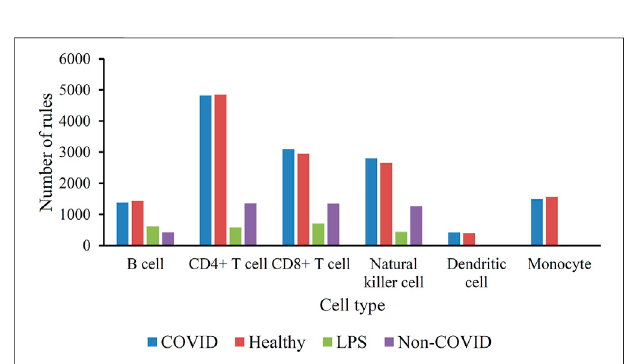
FIGURE 4 | Bar chart to show the number of classi fi cation rules for six cell types.